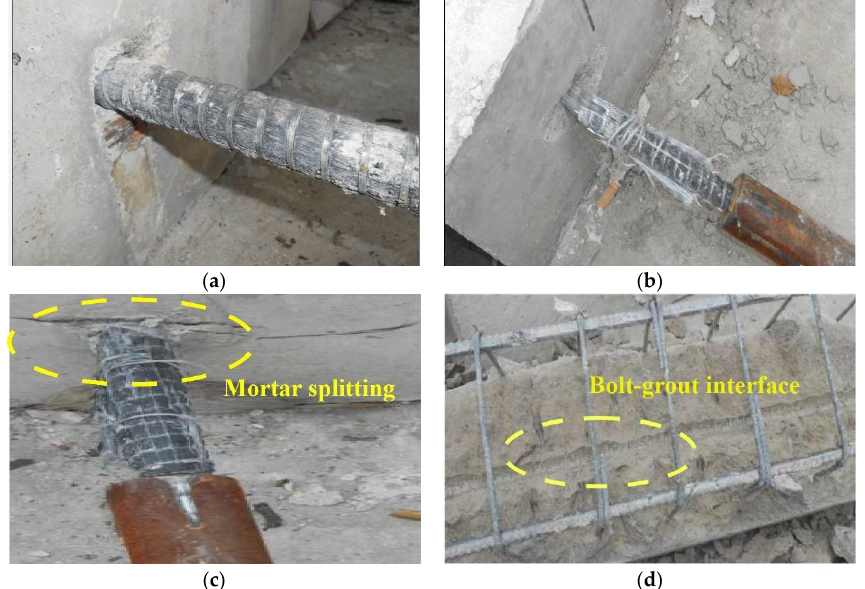
Figure 6. Failure modes of specimens. ( a ) GFRP bolt pulling out. ( b ) GFRP bolt breaking. ( c ) Mortar splitting. ( d ) Bolt-grout interface.